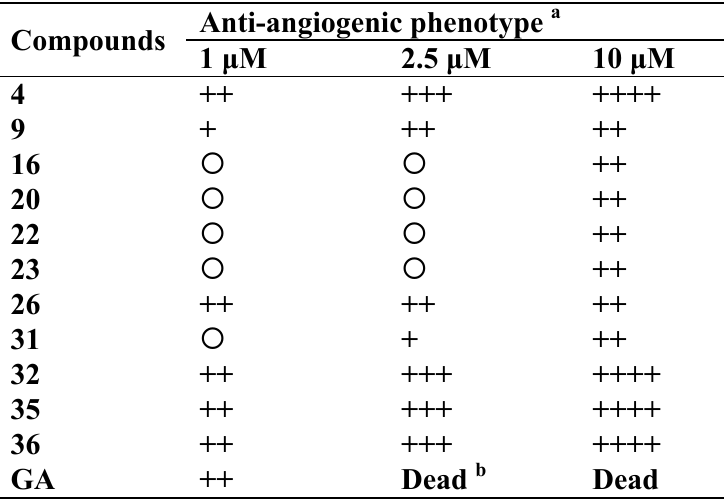
Table 1. Antiangiogenic effects in zebrafish embryos.